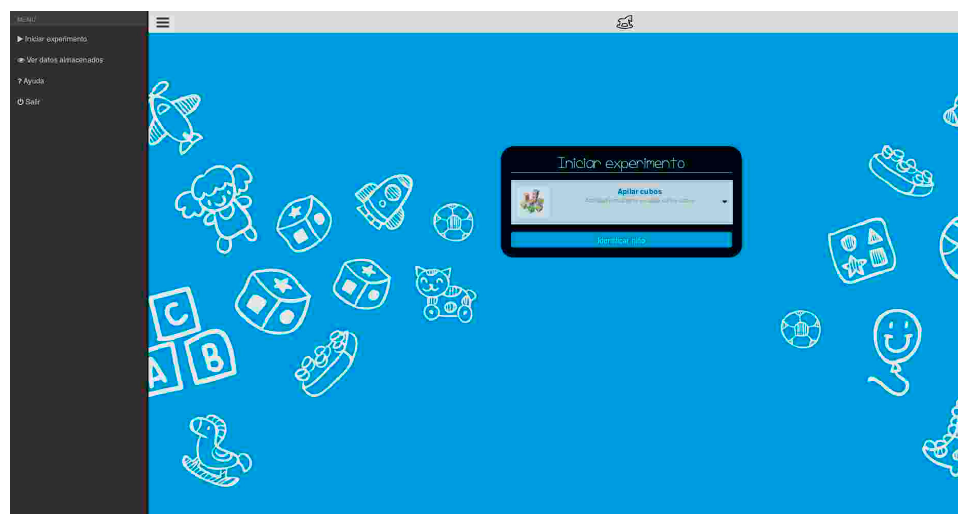
Figure 19. Collector Software architecture.